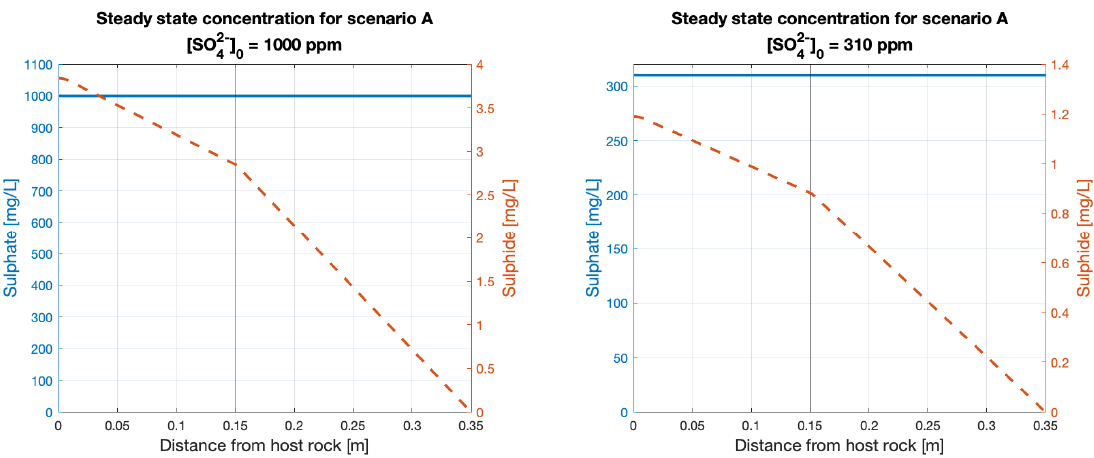
Profile concentrations at steady state for scenarios A and B.